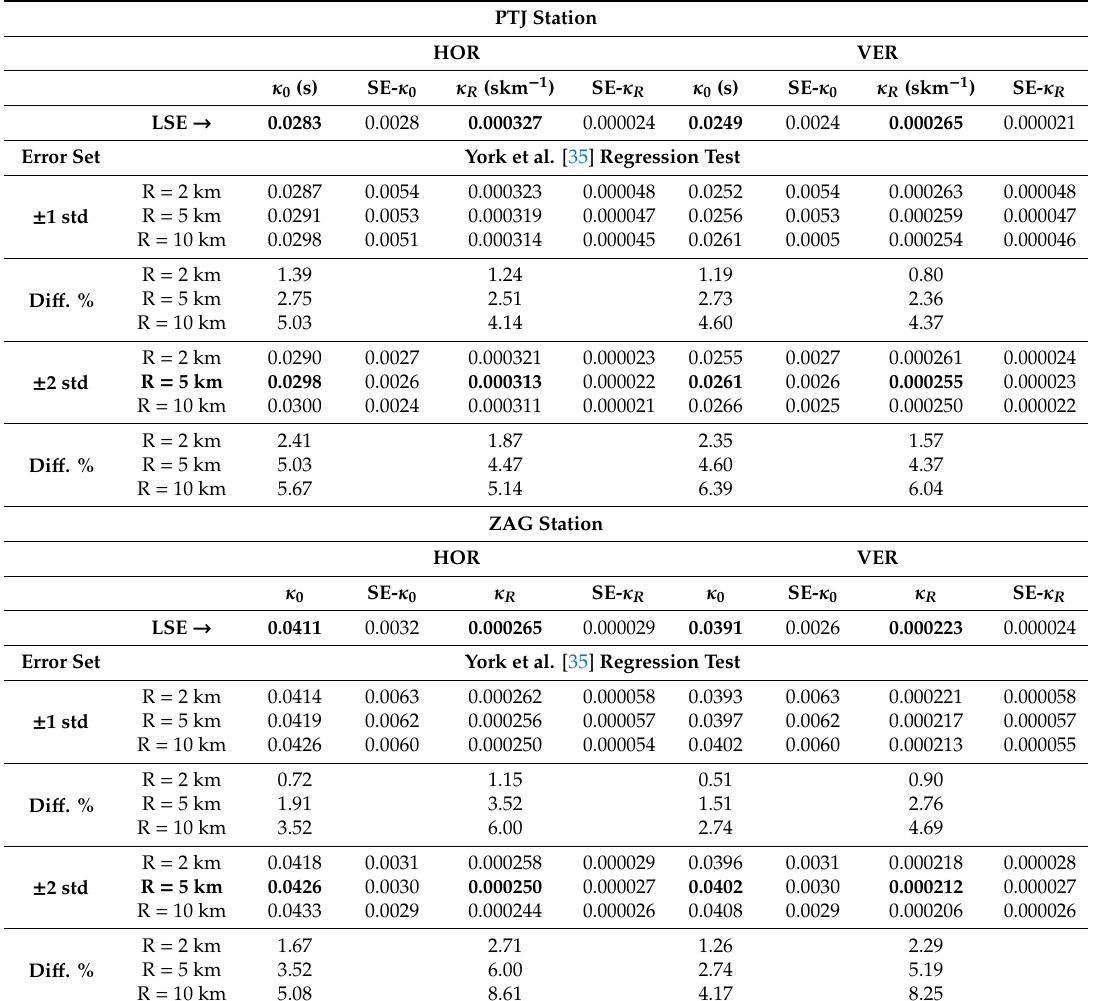
Table 1. Kappa regression model test using error-in-variables (method described in [35]) compared to linear least-square (LSE) regression with di ff erences (in